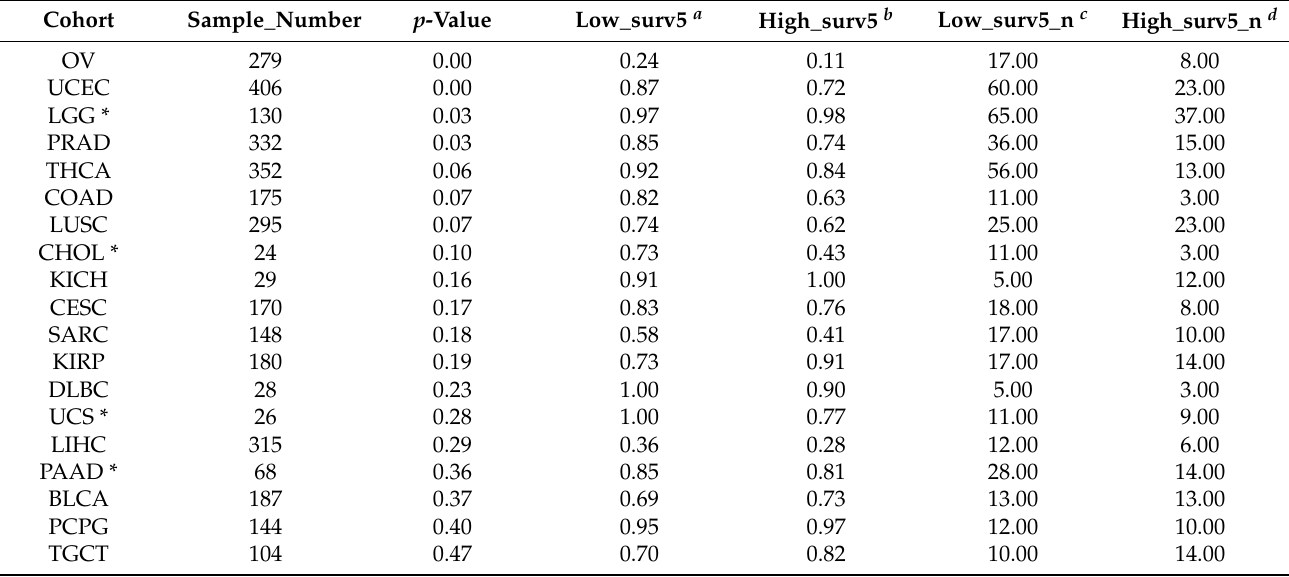
Table A3. Association between W-CIN and disease-free survival across cancer